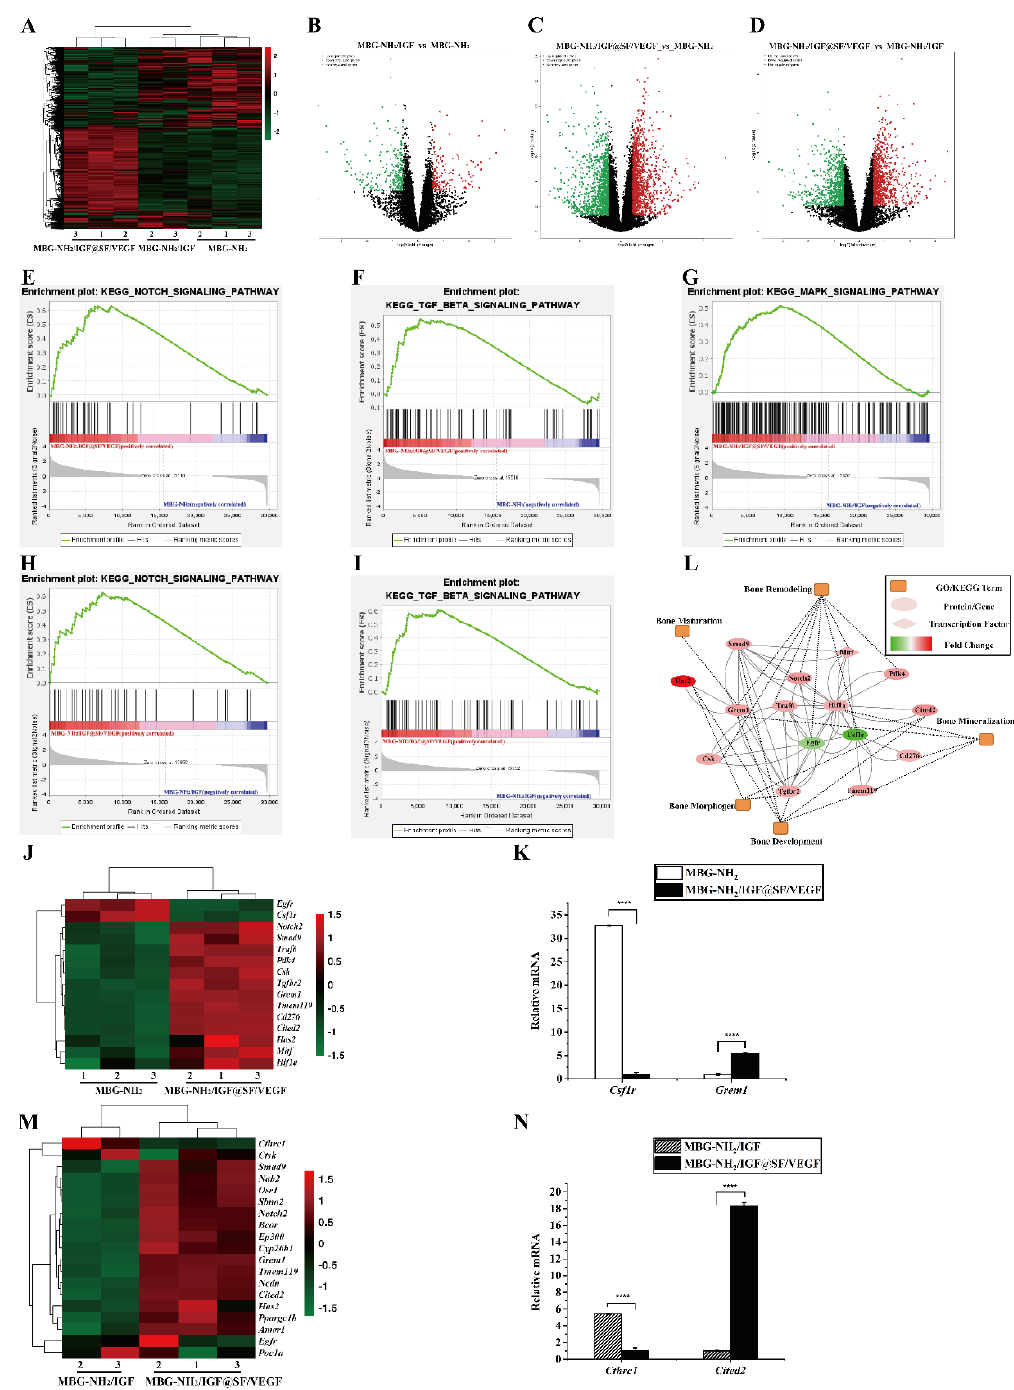
Figure 5. RNA-seq analysis of angiogenic effect on osteogenesis. Total RNA was extracted from BMSCs co-cultured with HUVECs on MBG-NH 2 , MBG-NH 2 /IGF and MBG-NH 2 /IGF@SF/VEGF scaffolds. ( A ) General heatmap of all the differentially expressed genes. ( B – D ) Volcano plots of all the differentially expressed genes between MBG-NH 2 /IGF and MBG-NH 2 scaffolds ( B ), MBG- NH 2 /IGF@SF/VEGF and MBG-NH 2 scaffolds ( C ), and MBG-NH 2 /IGF@SF/VEGF and MBG- NH 2 /IGF scaffolds ( D ). Increased expression genes are indicated by red dots, while decreased ex- pression genes are indicated by green dots. ( E – I ) Enrichment plots of GSEA analysis showing the KEGG Notch signaling pathway between MBG-NH 2 /IGF@SF/VEGF and MBG-NH 2 ( E ), the KEEG TGF- β signaling pathway between MBG -NH 2 /IGF@SF/VEGF and MBG-NH 2 ( F ), the KEEG MAPK